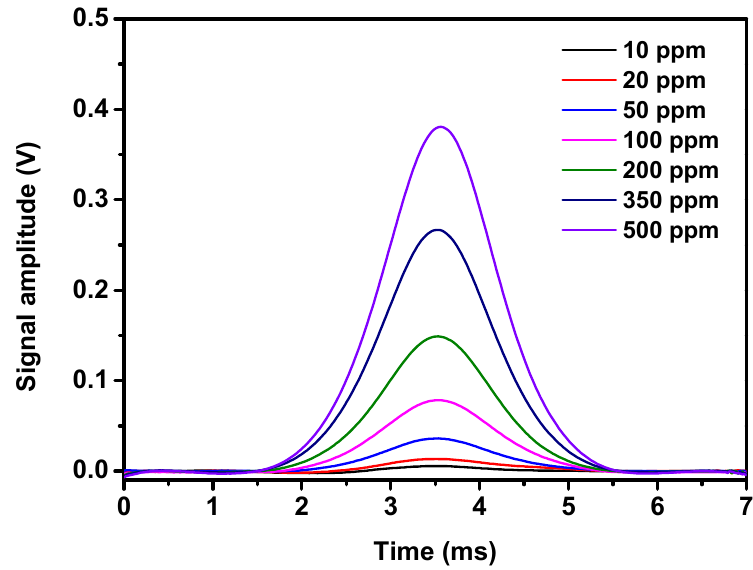
Figure 5. Measured signal amplitude of CO at different concentration levels. The signal amplitude as a function of CO concentration ranging from 10 ppm to 500 ppm is plotted in Figure 6. The calculated R-square value is 0.9998 in this CO sensor, which indicates that the response signal has an excellent linear response to the CO gas concentration.